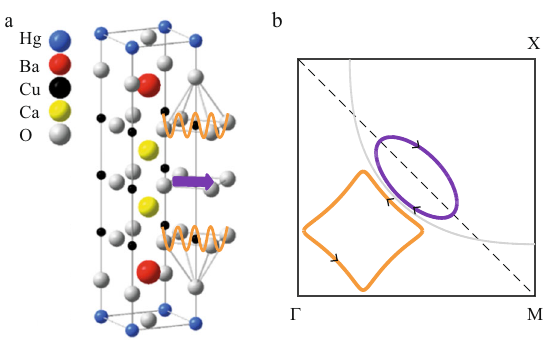
Fig. 4 Sketch of the Fermi surface. a Crystallographic structure of tri-layer Hg1223. We sketch the presence of AFM order in the IP (purple arrow) and charge order (orange wave) in the OPs. b Corresponding reconstructed Fermi surface in presence of AFM order in the IP leading to a hole pocket (purple, F 2 QO frequency) and CO order in the OP leading to an electron pocket (orange, F 3 QO frequency). Both pockets are located in the nodal region of the quarter of the fi rst Brillouin zone. Magnetic breakdown tunnelling between the pockets leads to an additional frequency F ≈ F − F 1 3 2